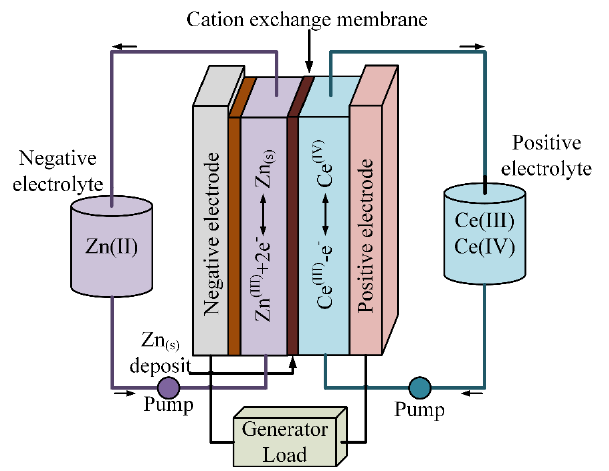
Figure 52. Schematic diagram of zinc-cerium flow battery; Zn/Zn2+ and Ce4+/Ce3+ redox reactions take place to produce electricity [160].